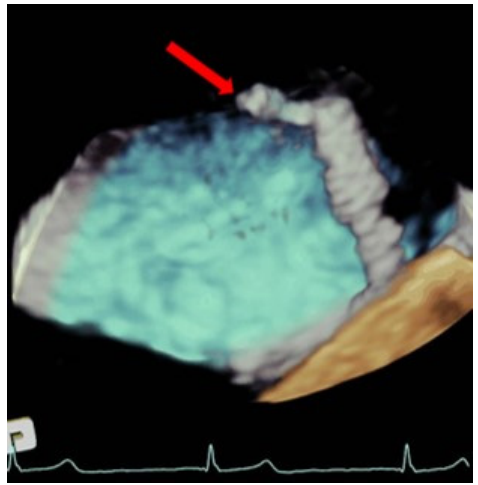
Figure 2. Three-dimensional transesophageal echocardiogram TEE image showing a large thrombus (red arrow) at the tip of the clip that is emerging from the delivery catheter within the left atrium.